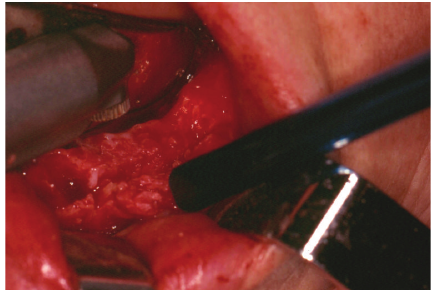
Figure 4: Excision of the tumour performed with Er:YAG laser